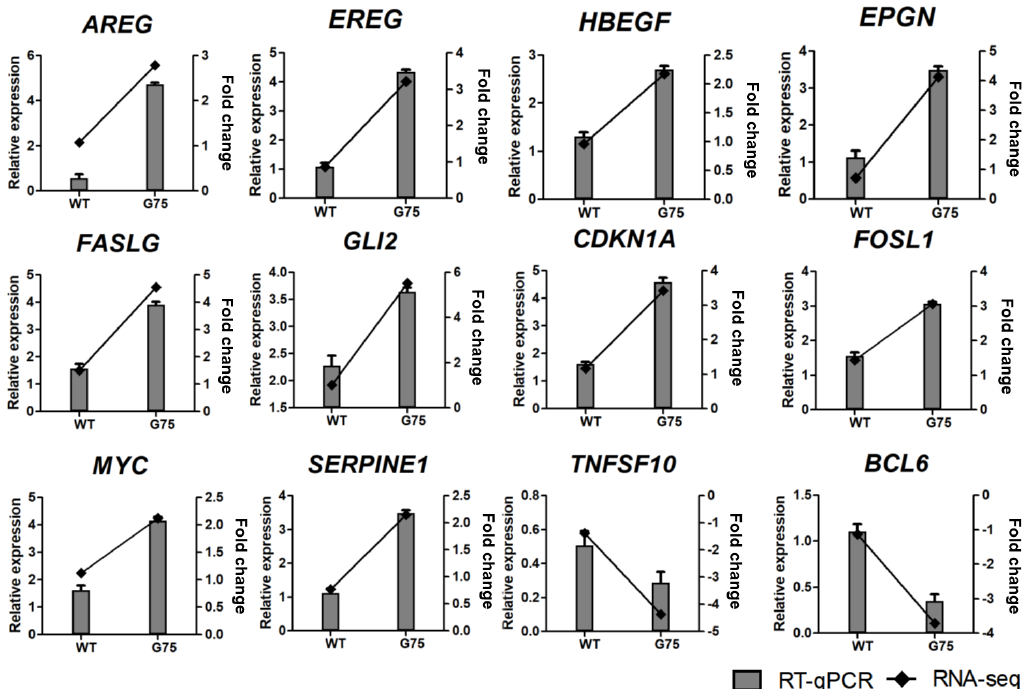
Figure 6. Real-time quantitative PCR validation of RNA-seq data for genes involved in cell survival and proliferation from HT-29 stimulated by CotG-p75. The right and left y-axis represent the fold change of RNA-seq data and relative expression of RT-qPCR data, respectively. The relative mRNA expression was compared with spore-untreated control. RT-qPCR analysis for mRNA expression of selected genes was normalized against GAPDH . RT-qPCR data are presented as mean ± standard deviation ( n = 3).